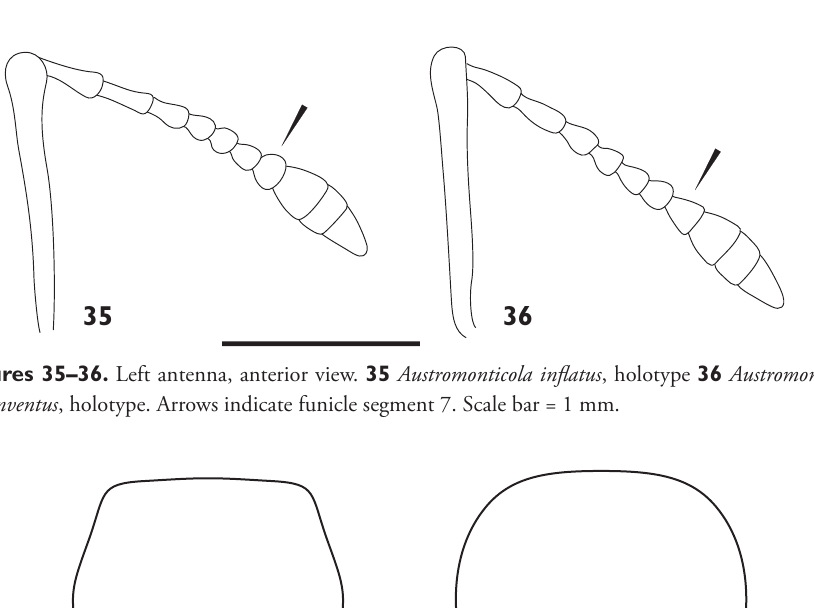
Figures 33–34. Rostrum, lateral view. 33 Austromonticola inflatus , arrow and dashed line indicates con- vex epifrons 34 Austromonticola postinventus , holotype, arrow and dashed line indicates flattened. Scale bars = 1 mm.